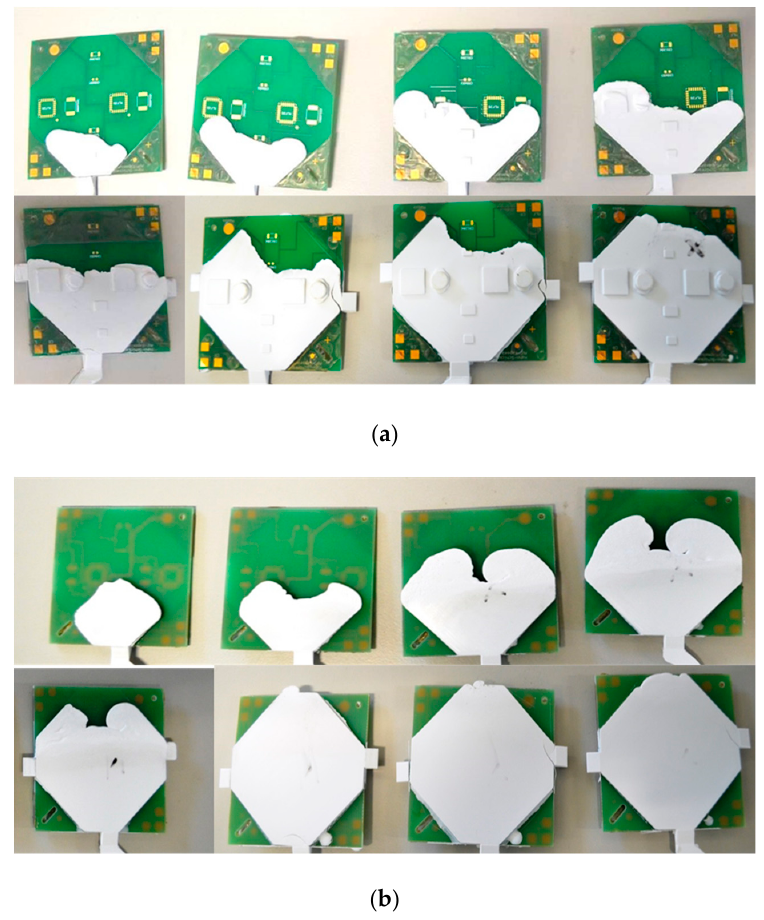
Figure 10. Filling behavior during MT01 on ( a ) mounting/front side but on an unmounted PCB, and ( b ) back side of the PCB.